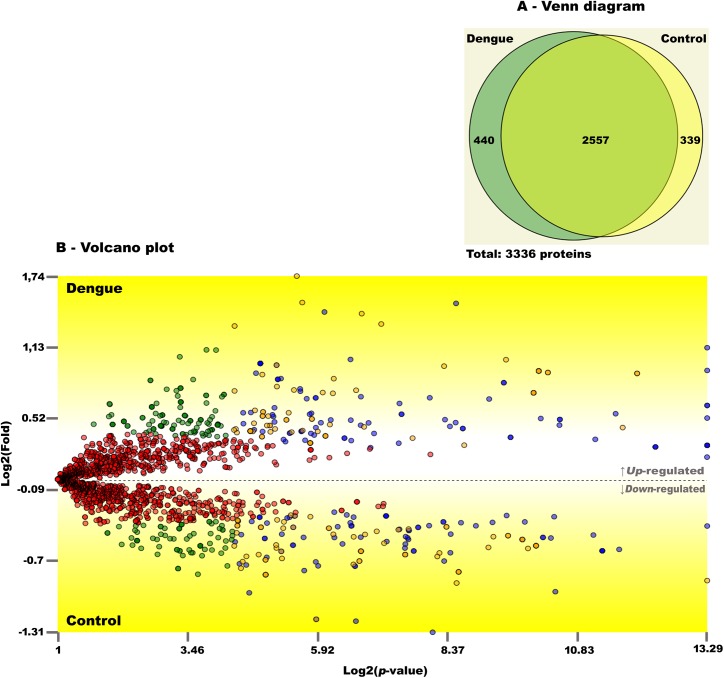
Distribution of mapped proteins in platelets from dengue patients and healthy volunteers.(A) Venn diagram of mapped protein entries present in platelets from healthy volunteers (Control) and patients with dengue. Both conditions shared 2,557 proteins; 339 and 440 proteins were identified only in control or dengue platelet samples, respectively. (B) Volcano plot of all shared protein entries and their abundance in dengue and control conditions. The graph represents TFold pairwise analysis of the two biological conditions. Each dot represents a protein mapped according to its log2 (fold change) on the ordinate axis and its -log2 (t-test p-value) on the abscissa axis. Red dots indicate proteins that satisfy neither the fold-change cutoff nor the FDR cutoff α (0.05). Green dots depict protein entries that satisfy the fold-change cutoff but not FDR α. Orange dots indicate proteins that satisfy both fold-change and FDR α, but present low fold changes. Blue dots represent protein entries that satisfy all statistical filters. The result shows 86 proteins significantly up-regulated (blue dots above the dotted line on Volcano plot) and 81 proteins down-regulated (blue dots below the dotted line on the graph) in platelets from patients with dengue.